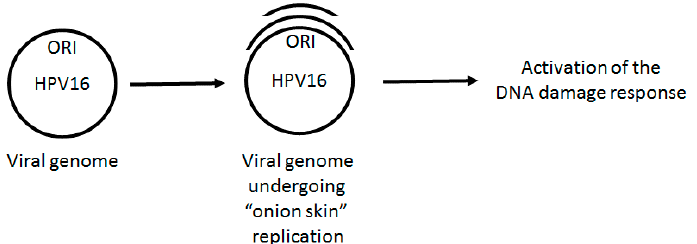
Figure 1. HPV E1–E2 mediated replication has the capacity to directly activate DNA damage repair pathways. Following infection, the viral genome must be quickly amplified to 20–50 copies per cell.